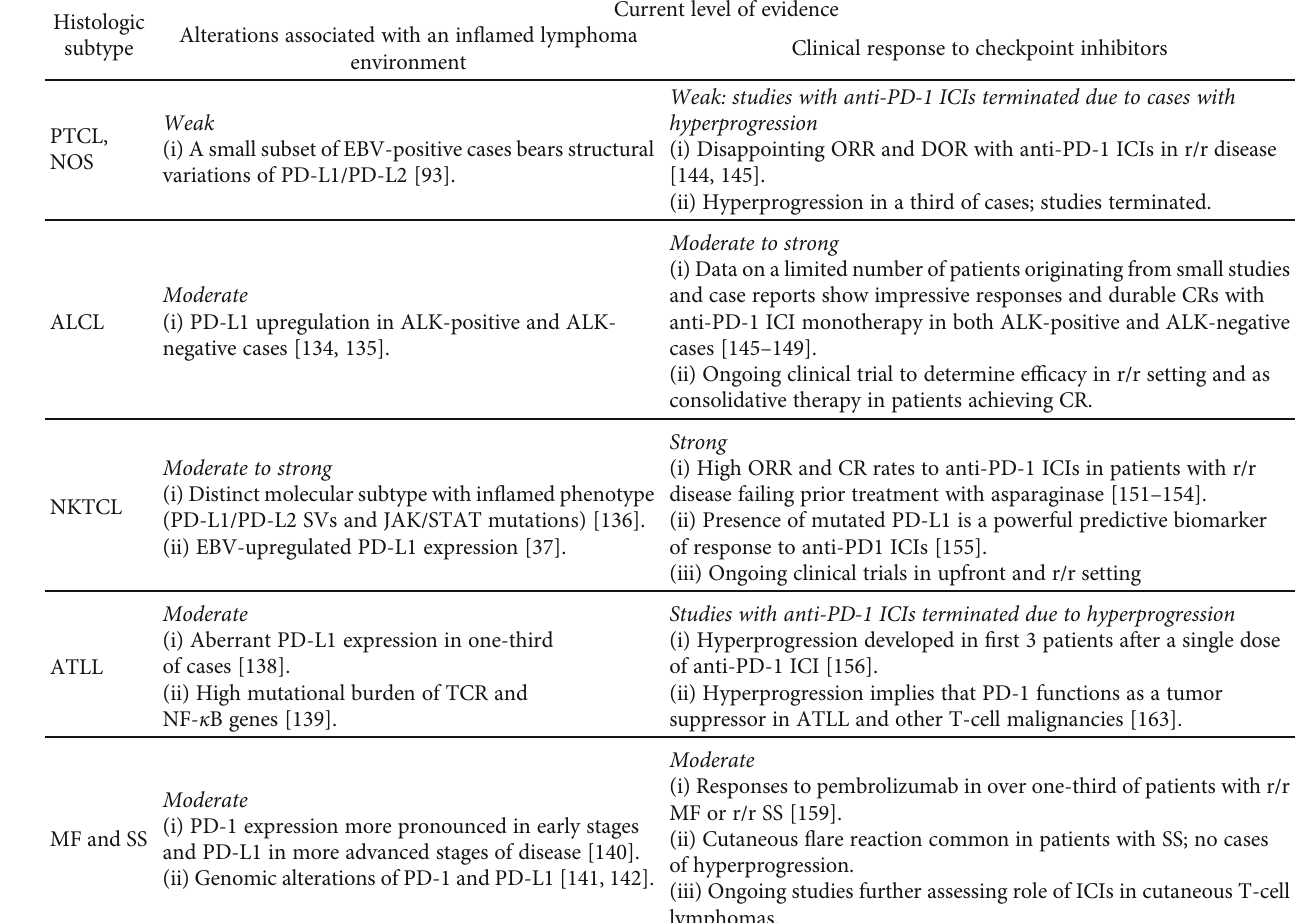
Table 2: Synopsis of current evidence and evolving role of checkpoint inhibitors in selected subtypes of T-cell NHL.